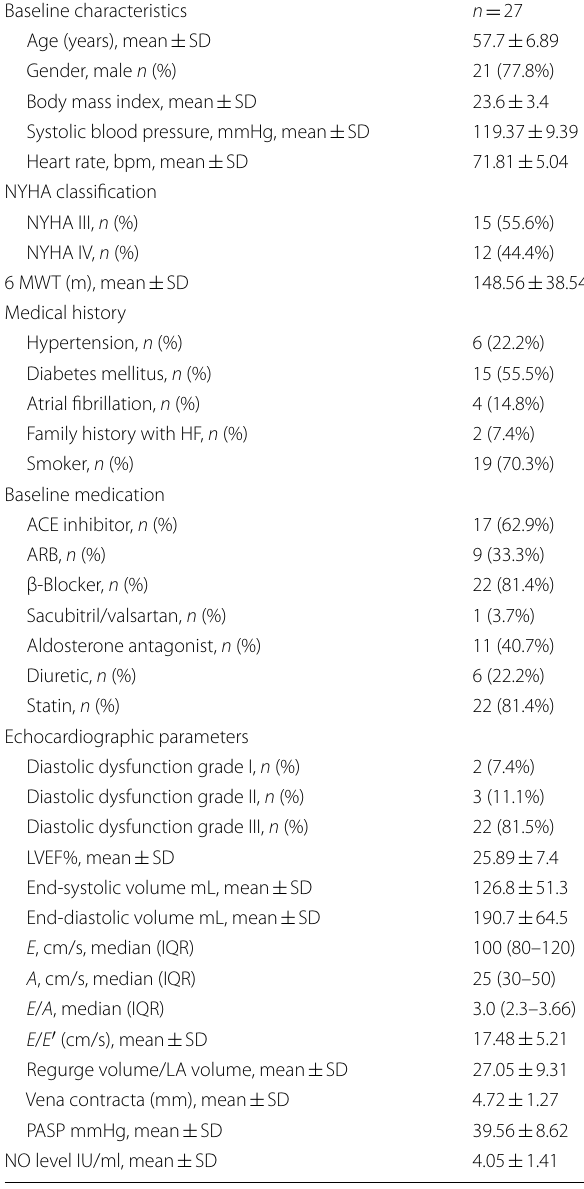
Table 1 Demographics and baseline characteristics of the